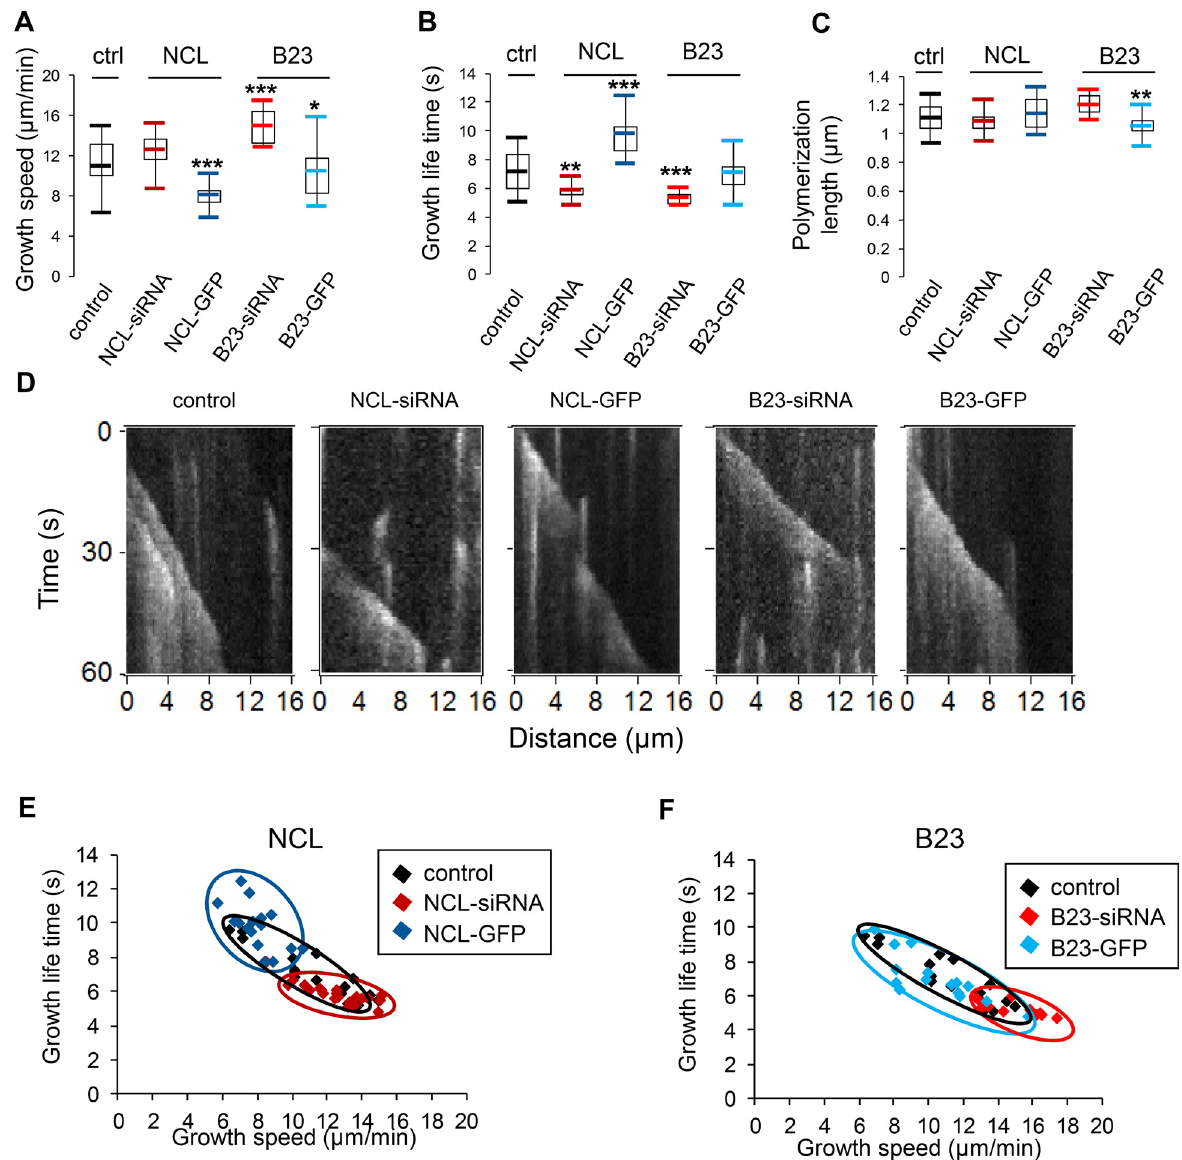
Fig 2. Nucleolin expression affects microtubule growth. (A)-(C): Box and whisker plots represent tracks for growth speed (A), growth life time (B) and growth displacement (C). For each condition (control [black], nucleolin depletion [dark red], nucleolin over expression [dark blue], B23 depletion [light red] and B23 over expression [light blue]), cells were individually analyzed (control: 18 cells; NCL-siRNA: 24 cells; NCL-GFP: 16 cells; B23-siRNA: 11 cells; B23-GFP: 15 cells). The mean value of the parameters was individually calculated in each cell. For each condition, the mean value of the parameters was obtained by averaging the value calculated for each cell. On the graphs, boxes indicate 25 and 75% quartiles and the whiskers extend to 1.5 times of the interquartile range. Outlier cells are not shown. The asterisks indicate that the mean values differ from the control condition with the Wilcoxon-Mann-Whitney two-sample rank test at different significance levels: 10% ( * P < 0.1), 5% ( ** P < 0.05), 0,5% ( *** P < 0.005). (D) Kymographs of a single microtubule segment from the time-lapse series for each condition. (E)-(F) 2D graphs showing the repartition of the cells according to growth speed (x-axis) and growth life time (y-axis). Control [black], nucleolin over expressing [dark blue] and nucleolin depleted [dark red] or B23 over expressing [light blue] and B23 depleted [light red]. Cells are represented by the squares. Entire cell area were individually analyzed for each condition [control: 18 cells / NCL-siRNA: 24 cells / NCL-GFP: 16 cells / B23-siRNA: 11 cells / B23-GFP: 15 cells]. In all, thousands of microtubules were analyzed for each condition [control: 16262 microtubules / NCL-siRNA: 42737 microtubules / NCL-GFP: 10215 microtubules / B23-siRNA: 15915 microtubules / B23-GFP: 12664 microtubules]. The mean values of growth parameters are shown [speed ( μ m/min) / life time (s) / displacement ( μ m)]. σ is the standard